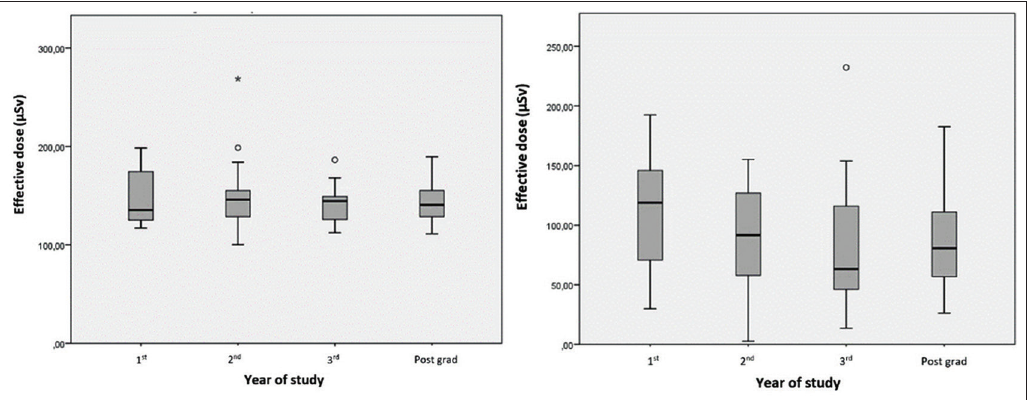
FIGURE 4. Effective dose comparison between study years for anteroposterior view (left) and lateral view (right) of useful images of the lumbar